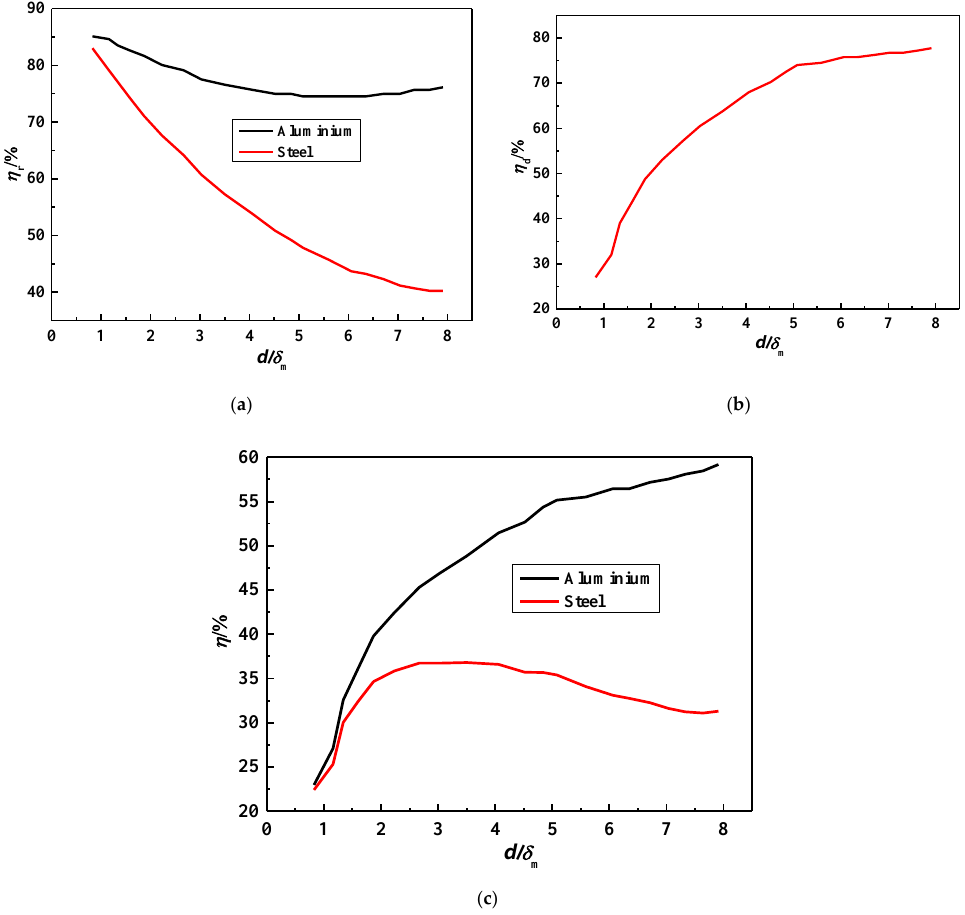
Figure 3. Thermal efficiency, electrical efficiency, and electrothermal efficiency of the medium-frequency induction furnace. ( a ) thermal efficiency η r ; ( b ) electrical efficiency η d ; ( c ) electrothermal efficiency η .